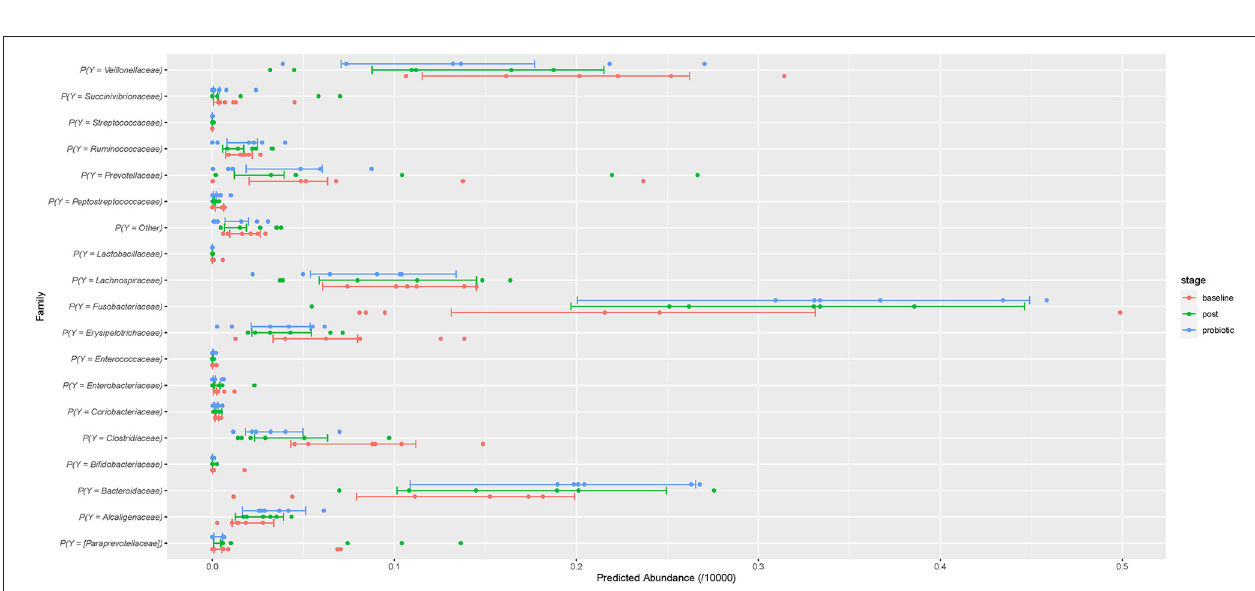
FIGURE 3 | (A) PCoA using Bray-Curtis dissimilarity index. The percentage of variation explained by the principal coordinates (PC1 and PC2) is indicated on the axes (color of data points reflects stage of trial, red baseline, blues for during probiotic administration and greens for post-administration). (B) Distance boxplots of the differences in relative abundance between the baseline and the post-treatment sample from the same dog, measured as Bray-Curtis dissimilarity index.